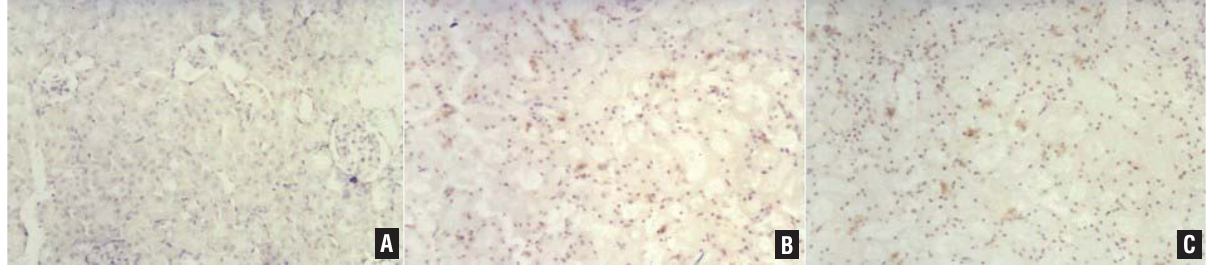
Figure 4 - Histology fi gures of P-Selectin expression in the three groups. A) Control; B) IR; C)